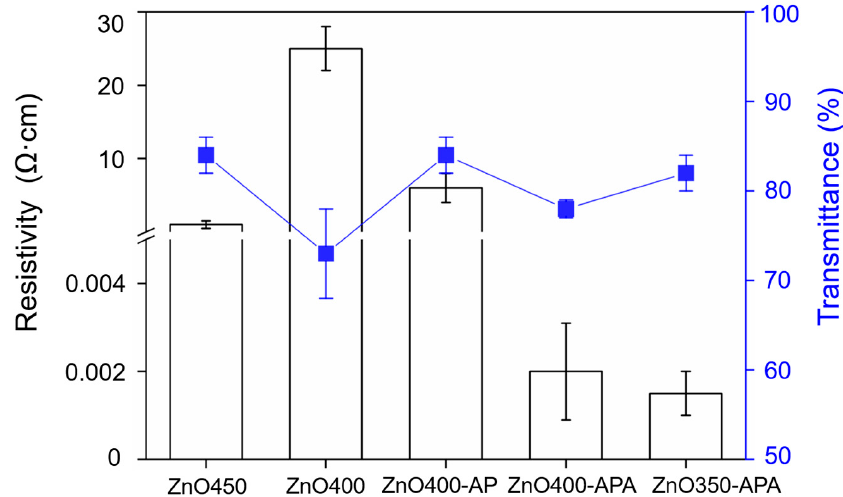
Figure 7. Resistivity and transmittance of ZnO coatings.